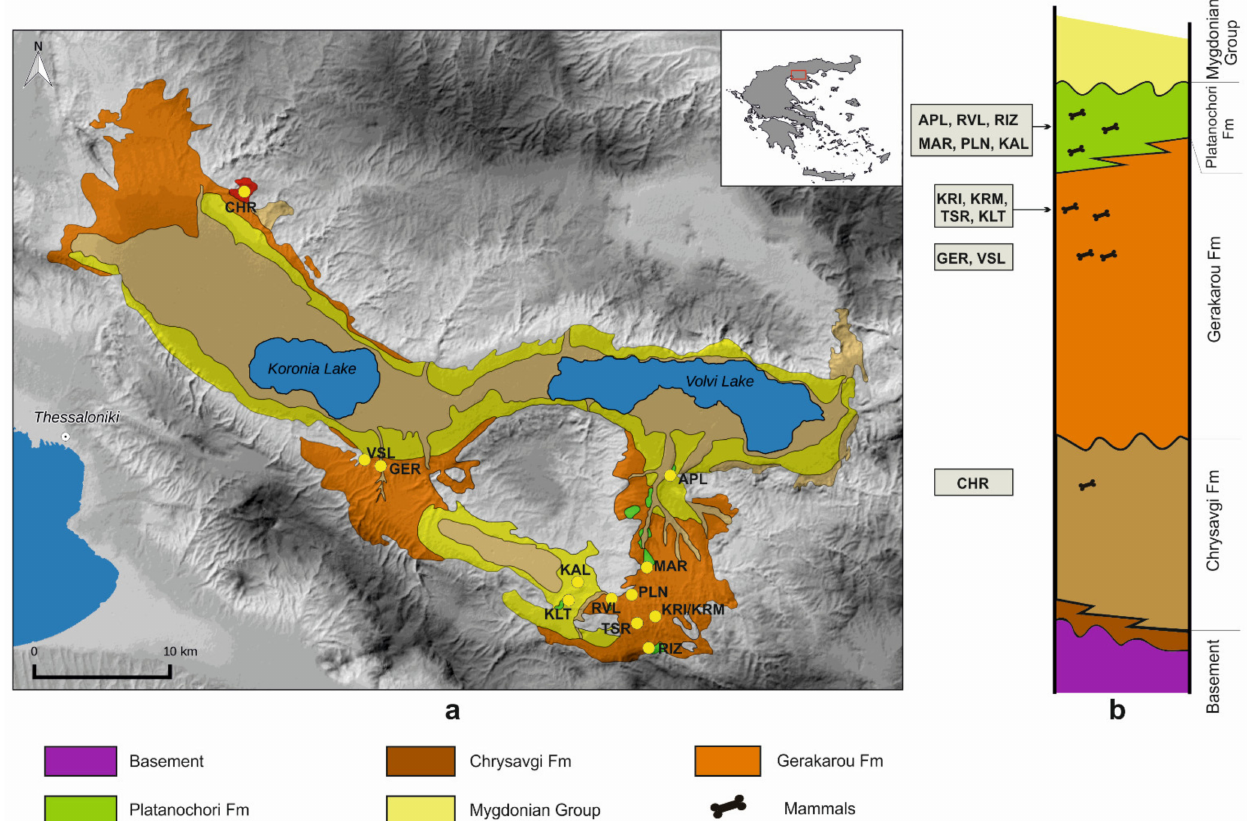
Figure 1. ( a ) Geological map of the Neogene and Quaternary lithostratigraphic units of the Mygdonia Basin (map and data from [55]; modified by [31]); ( b ) simplified composite stratigraphic column of the Mygdonia Basin indicating the position of the fossiliferous